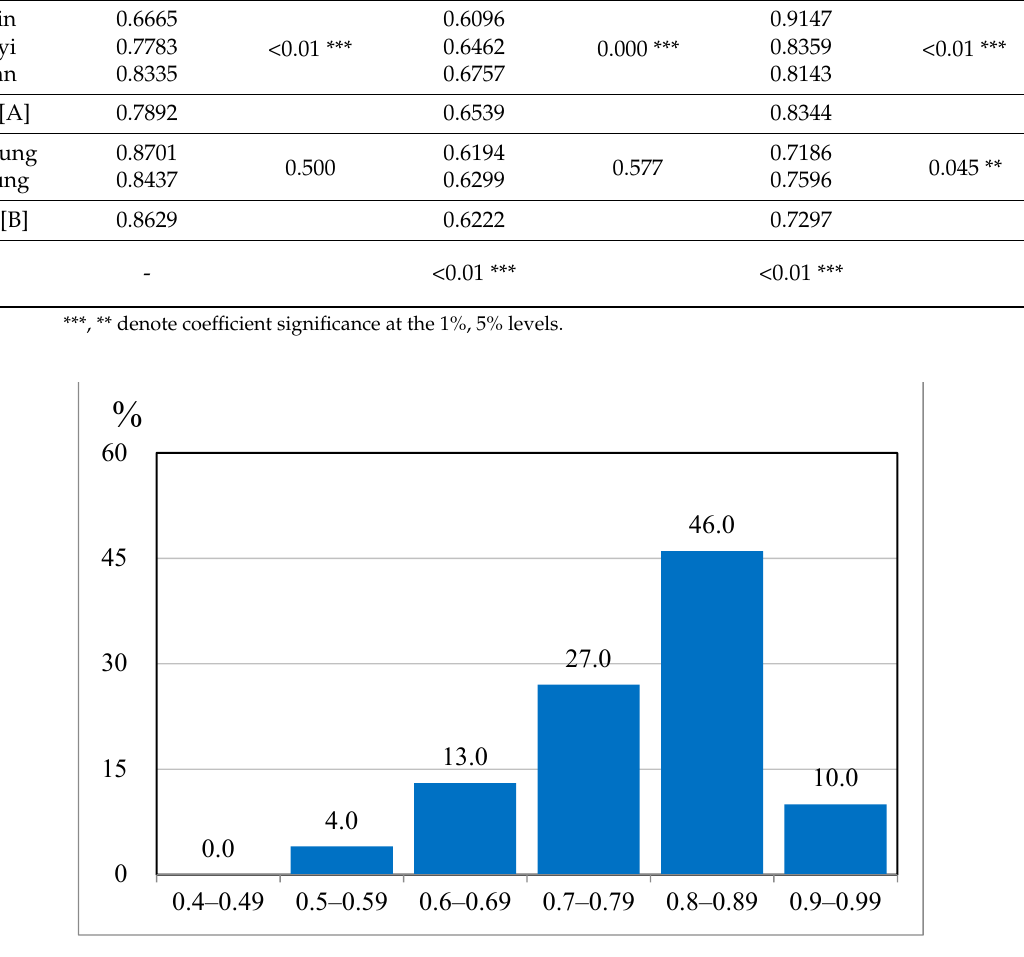
Figure 5. Distribution of group technical efficiency (GTE) scores of Current Year Harvest.